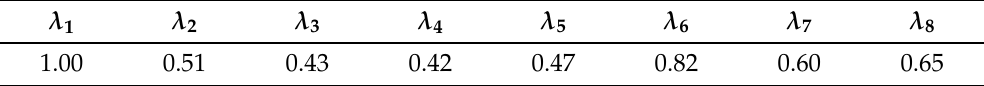
Table 2. Progressive coefficients generated with the Salary/life expectancy